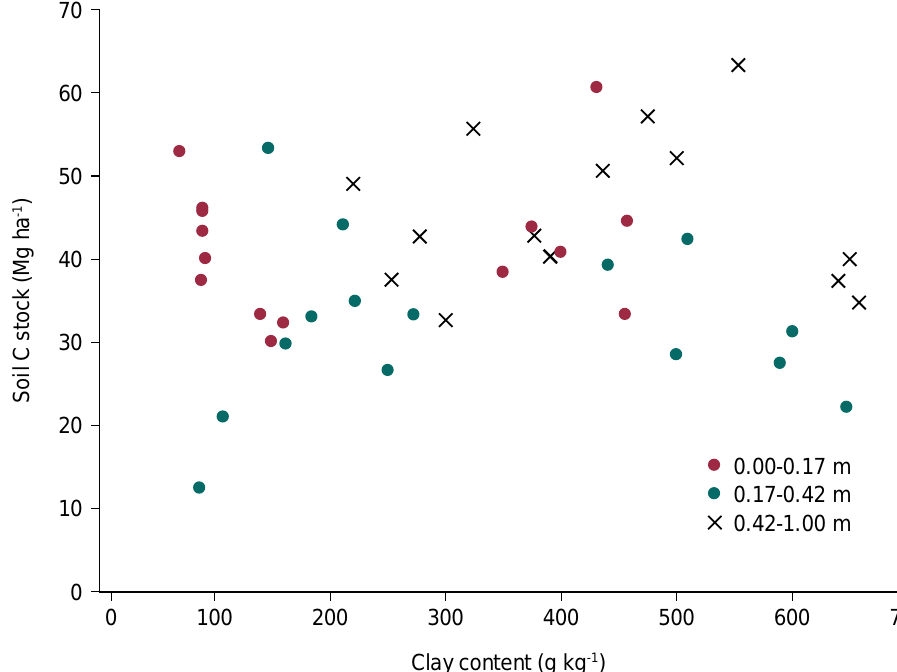
Figure 2. Relationship between soil organic carbon stock and clay fraction content for the native forest